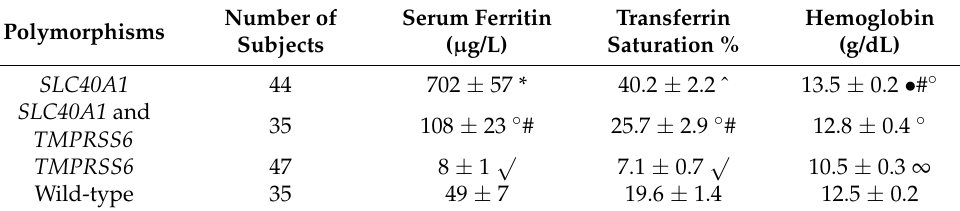
Table 5. Biochemical parameters of the individuals carrying SLC40A1 (44–24G>C and/or 663T>C) polymorphisms only, indicated as SLC40A1 , both SLC40A1 and TMPRSS6 c.2207T>C SNPs ( SLC40A1 and TMPRSS6 ), and only TMPRSS6 c.2207T>C polymorphism ( TMPRSS6 ), compared to the wild-type healthy group of participants